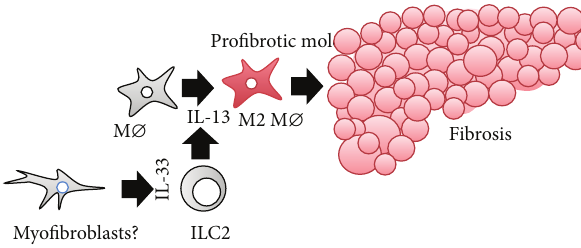
Figure 5: IL-33–ILC2–IL-13 axis-mediated liver fibrosis. The IL- 33–ILC2–IL-13 axis is important for physiological wound healing. The same process is involved in the development of liver